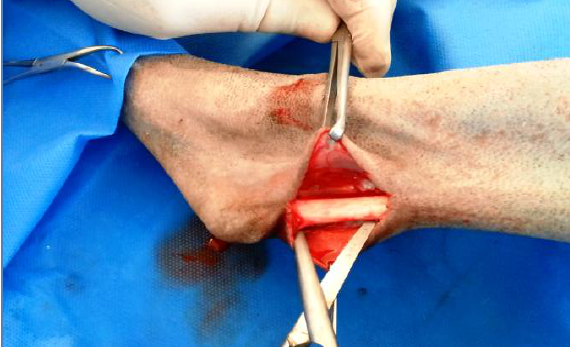
Figure, 1: Skin is incised and blunt dissection is made to separate the tendon from the surrounding structures.